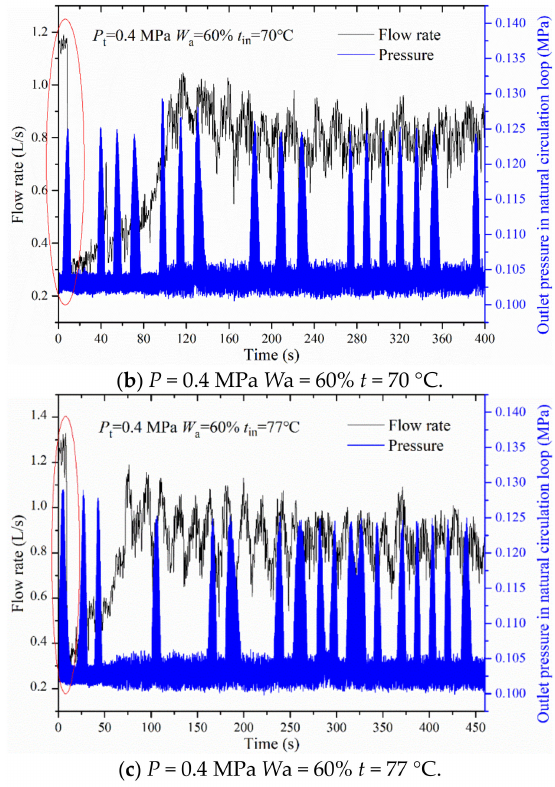
Figure 8. The response of the system to a sudden change in the valve opening.